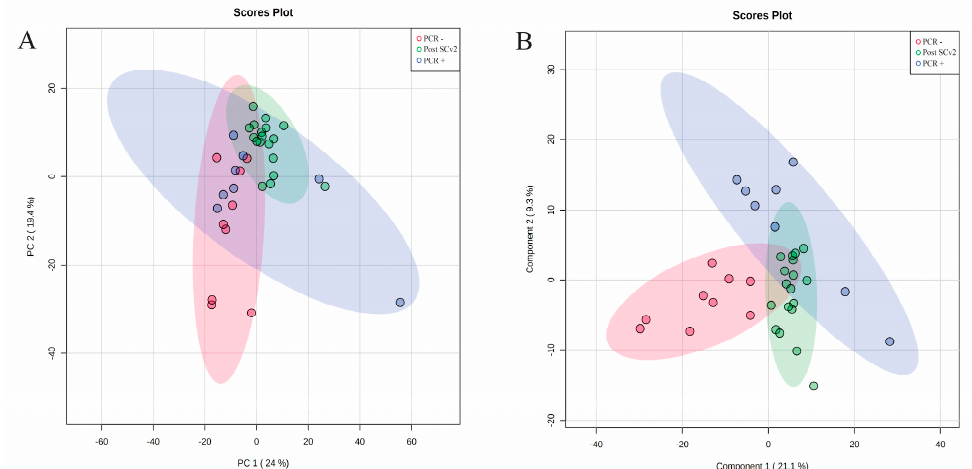
Figure 1. ( A ) PCA; and ( B ) PLS-DA comparing subjects from PCR − , PCR+, and post-SARS-CoV-2 infection